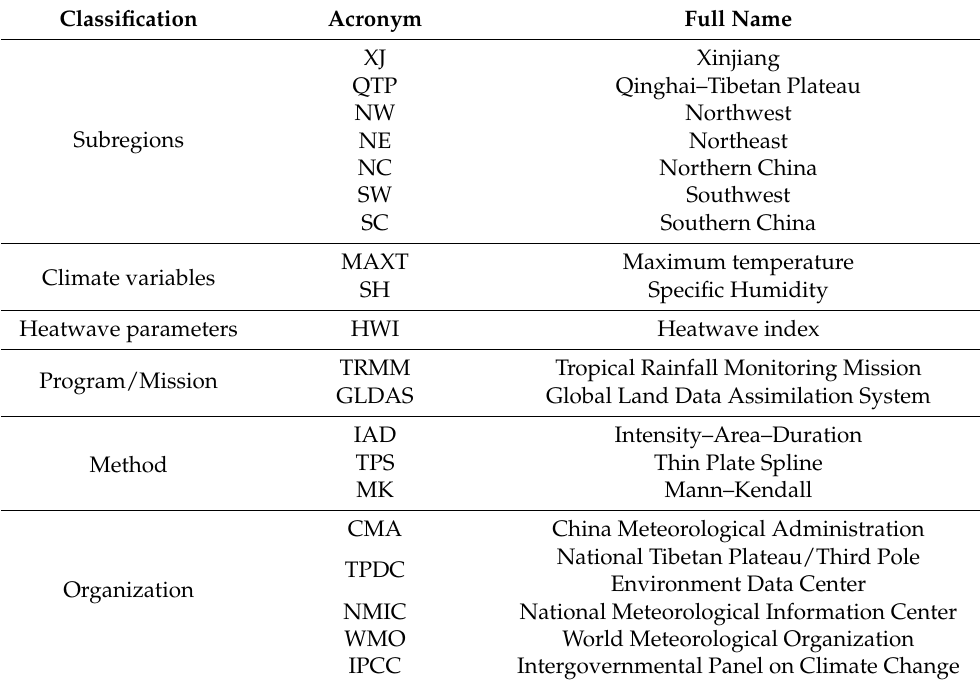
Table A1. All acronyms and corresponding full names presented in this